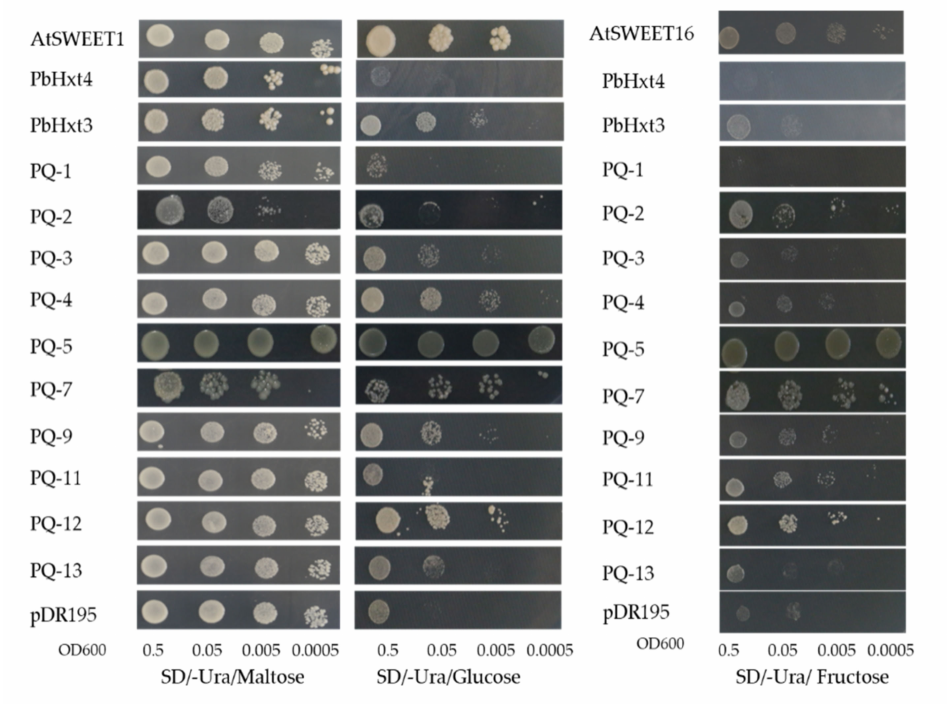
Figure 4. Complementation of yeast EBY.VW4000 with sugar transporter genes of Plasmodiophora brassicae . Growth of the yeast mutant strain EBY.VW4000 expressing the P. brassicae sugar transporter genes in SD (-Ura) solid media supplemented with 2% maltose, 2% glucose, and 2% fructose. To verify that the EBY.VW4000 strain grew on a non-hexose medium, 2% maltose was used as a positive control. AtSWEET1 was used as a positive control for glucose uptake. AtSWEET16 was used as a positive control for fructose uptake. The pDR195 empty vector was used as a negative control. Images show growth at 30 ◦ C for 3